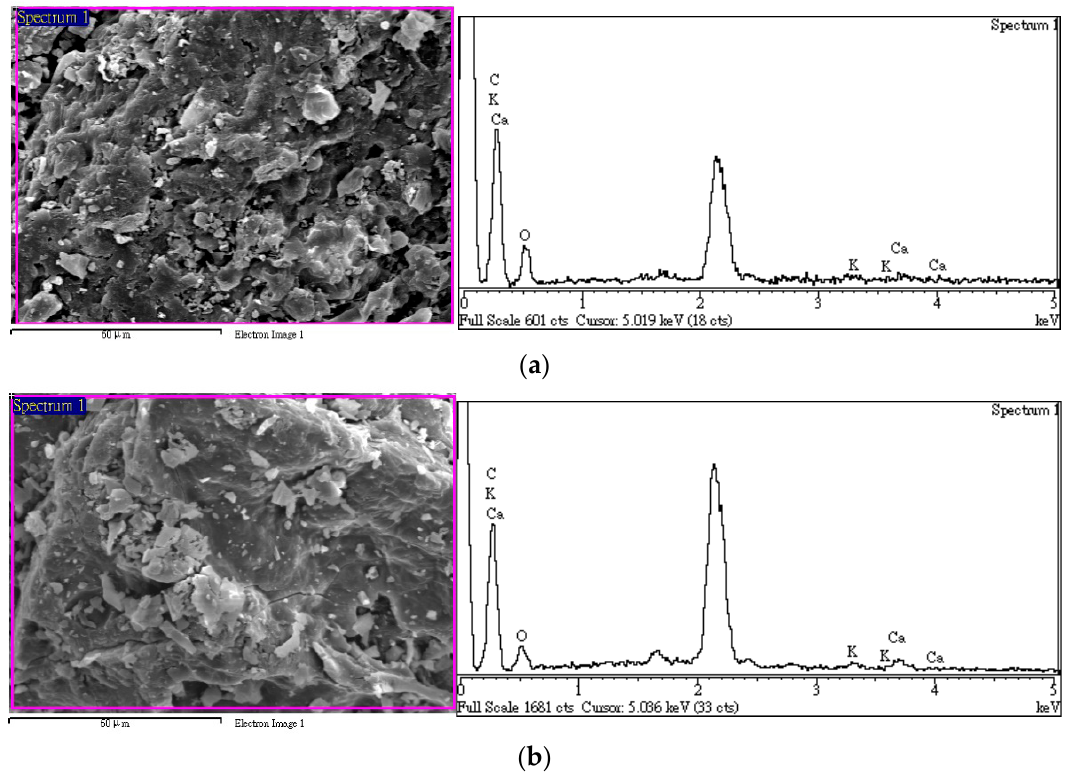
Figure 4. SEM/EDS analyses of ( a ) a feedstock SP and ( b ) optimal SP-torrefied product (T-SP-280-30).